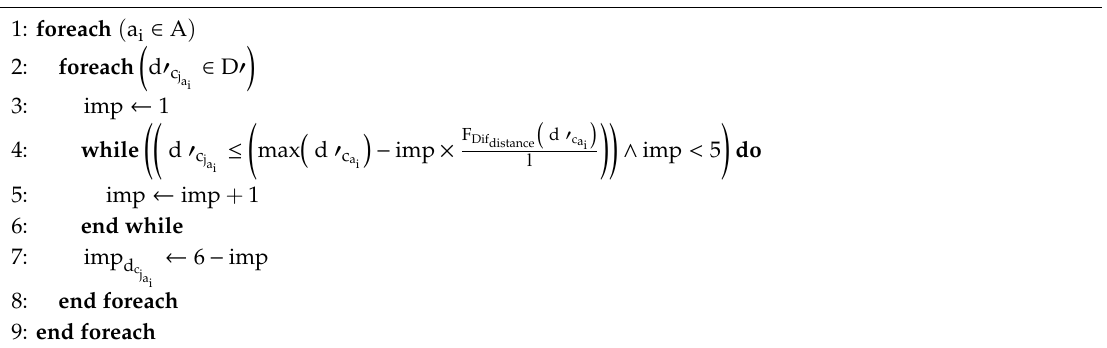
Algorithm 4. The relevance that the value of each criterion c j has in alternative a i based on an overall appreciation of the criterion value in all alternatives.